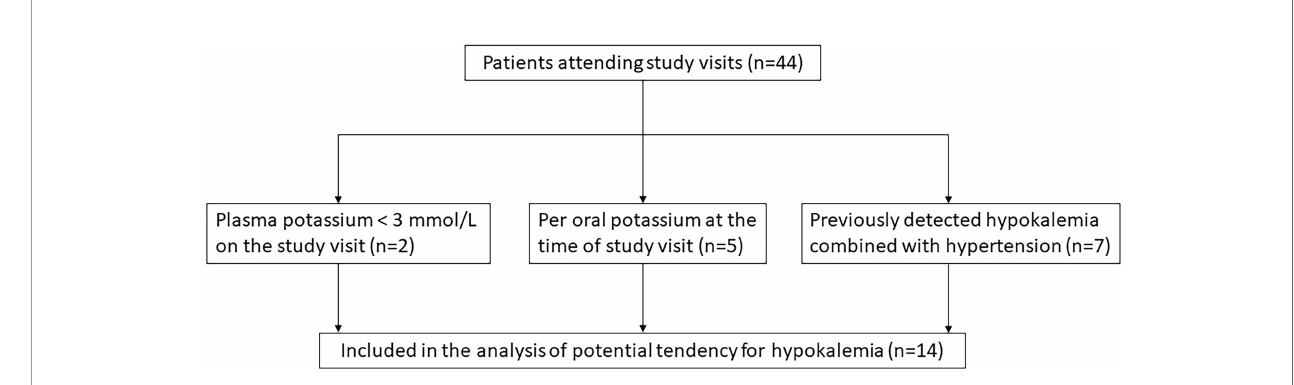
FIGURE 1 | Selection of patients with potential tendency for hypokalemia among 44 patients